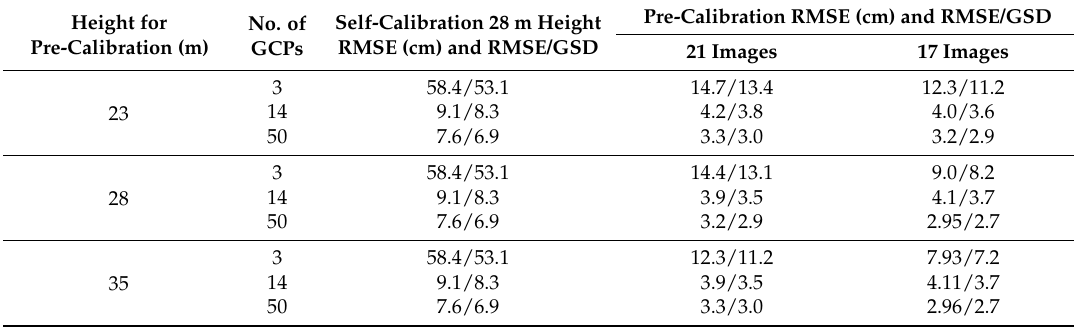
Table 10. The residuals of 99 CPs for a 35 m nadiral flight when using self-calibration and pre-calibration at 3 different heights: 23 m, 28 m and 35 m in the case of a different number of GCPs. Height for Pre-Calibration